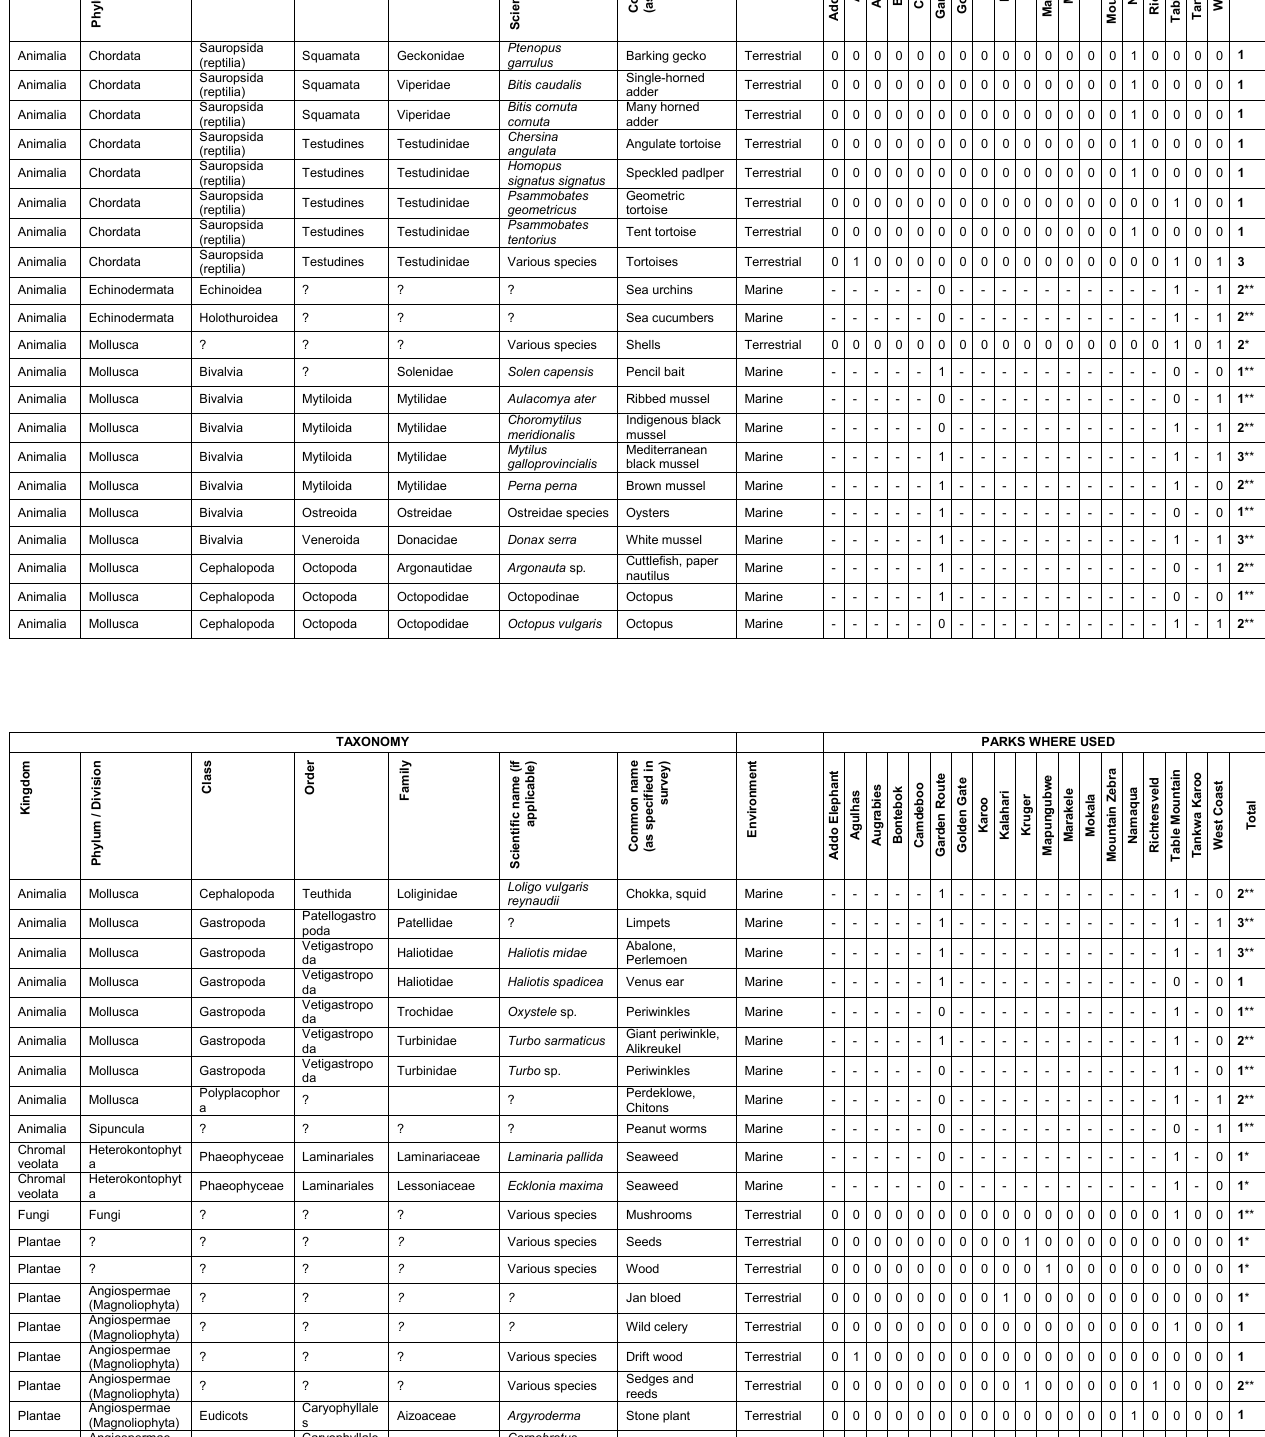
Plantae Angiospermae (Magnoliophyta) ? ? ? Various species Sedges and reeds Terrestrial Plantae Angiospermae (Magnoliophyta) Eudicots Caryophyllale s Aizoaceae Argyroderma Stone plant Terrestrial Plantae Angiospermae (Magnoliophyta) Eudicots Caryophyllale s Aizoaceae Carpobrotus acinaciformis Sour figs Terrestrial Plantae Angiospermae (Magnoliophyta) Eudicots Caryophyllale s Aizoaceae Carpobrotus edulis Suurvye,